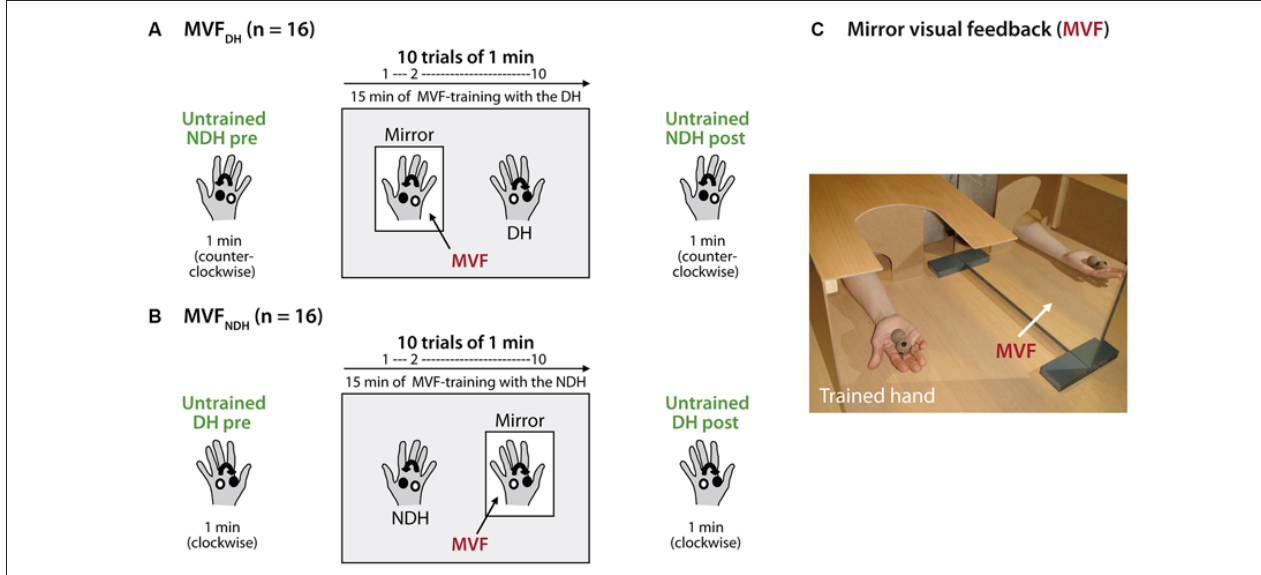
FIGURE 1 | Experimental setup and design. Volunteers performed a complex ball-rotation task with two cork balls. (A) Volunteers in MVF DH rotated the balls with their non-dominant hand (NDH) in a counterclockwise direction for 1 min (untrained hand pre), followed by a 15 min training period with the dominant hand (DH) in a clockwise direction while mirror visual feedback (MVF) was provided (10 trials of 1 min each with 30 s break in between). After the training phase, the performance of the NDH was retested (untrained hand post). (B) Volunteers in MVF NDH received the same instructions and conducted the same task just vice versa : MVF-training was performed with the NDH while the DH was assessed before and after MVF (untrained hand pre and post). In both groups, volunteers rotated the balls with the NDH always in a counterclockwise direction and with the DH always in a clockwise direction. (C) During the task, volunteers in both groups were seated in a comfortable chair with their elbows flexed at 90 ◦ and with their pronated hands rested on a desk in front of them. While MVF was provided, a mirror was placed in the subject’s midsagittalplane and the performing hand was covered by a wooden barrier to prevent direct view. See text for details.